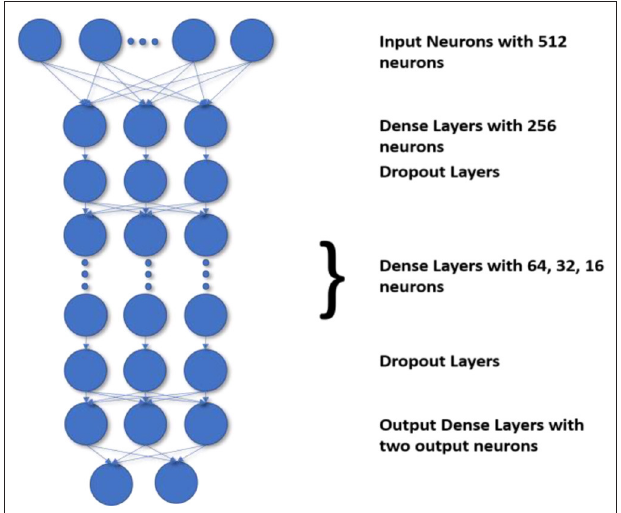
FIGURE 2 | Structure of ANN in each node of Decision Tree in the proposed